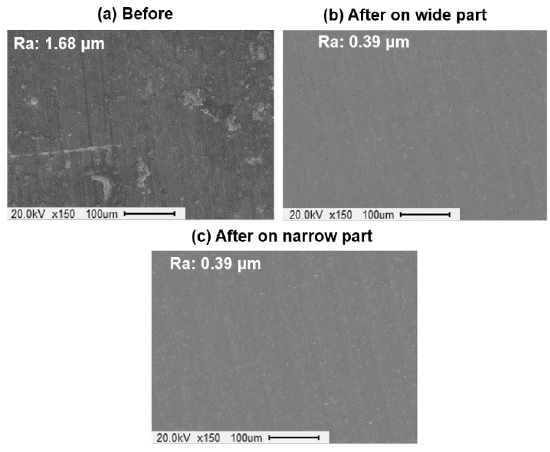
Figure 8. SEM micro picture of the inner surface of the cone pipe, ( a ) before finishing, ( b ) on the wide part after finishing, ( c ) on the narrow part after finishing.